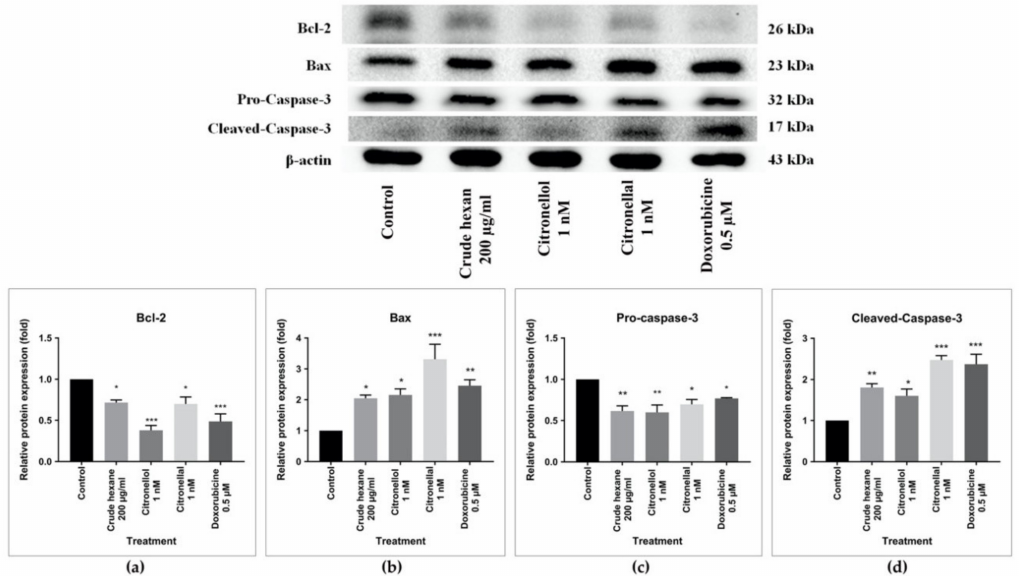
Figure 8. WesternBlotanalysison: ( a )Bcl-2protein,( b )Baxprotein,( c )Pro-Caspase-3,( d )Cleaved-Caspase-3. Full length of Western blot analysis (Figure S3). Data are expressed as mean ± SEM. One-way ANOVA wasusedtoanalyzethedi ff erencebetweencontrolgroupandtreatmentgroups, p value < 0.05considered significant (* p < 0.05, ** p < 0.01, *** p <